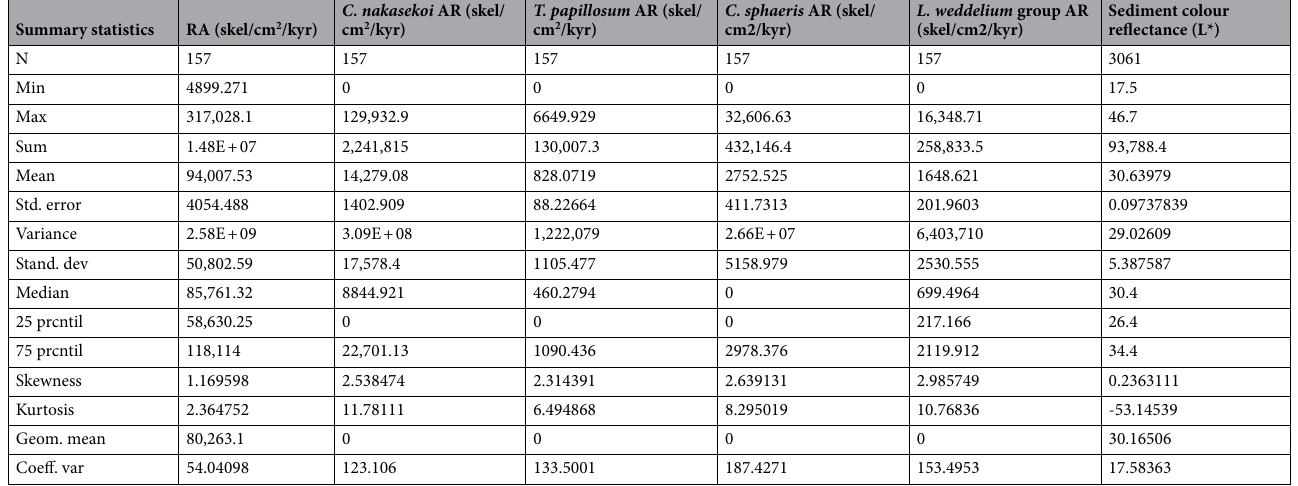
Table 1. Basic statistics on used environmental variables in this